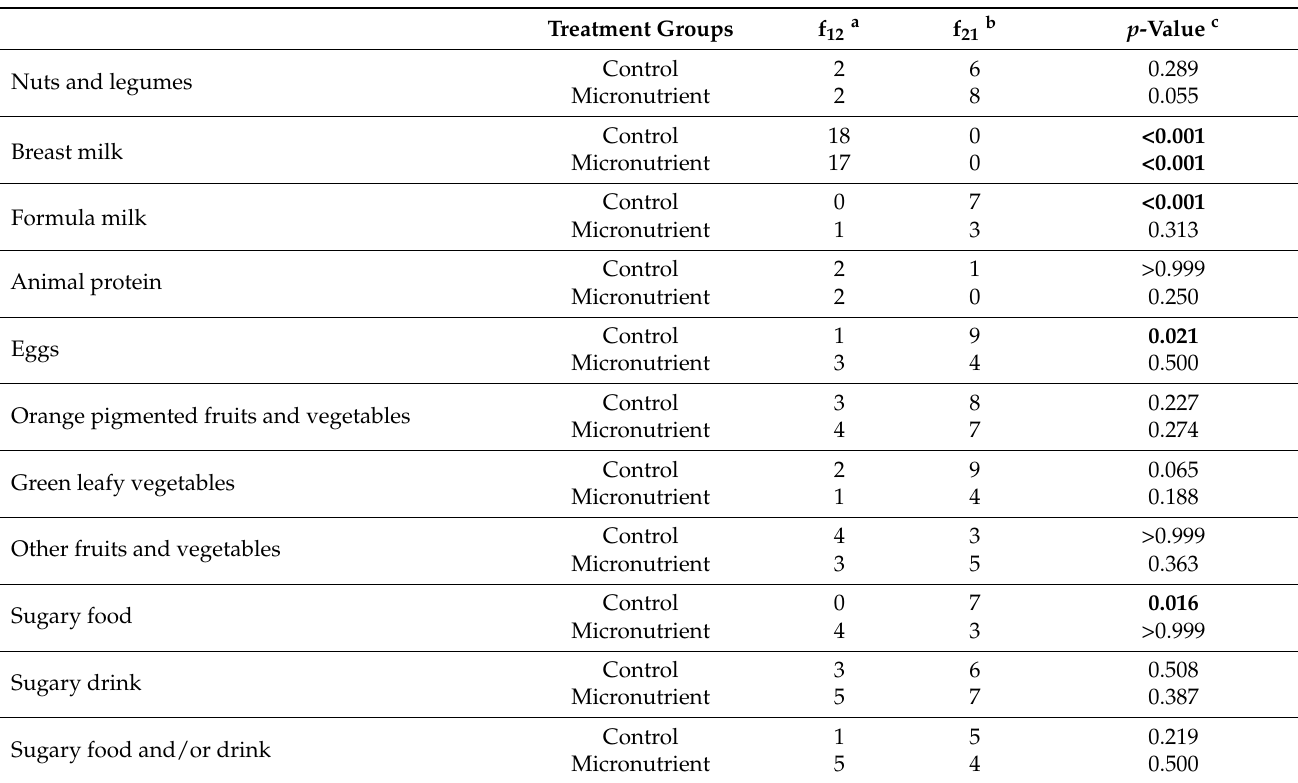
Table 5. Comparisons of food groups, stratified by treatment arms, before and after intervention was instituted ( n =